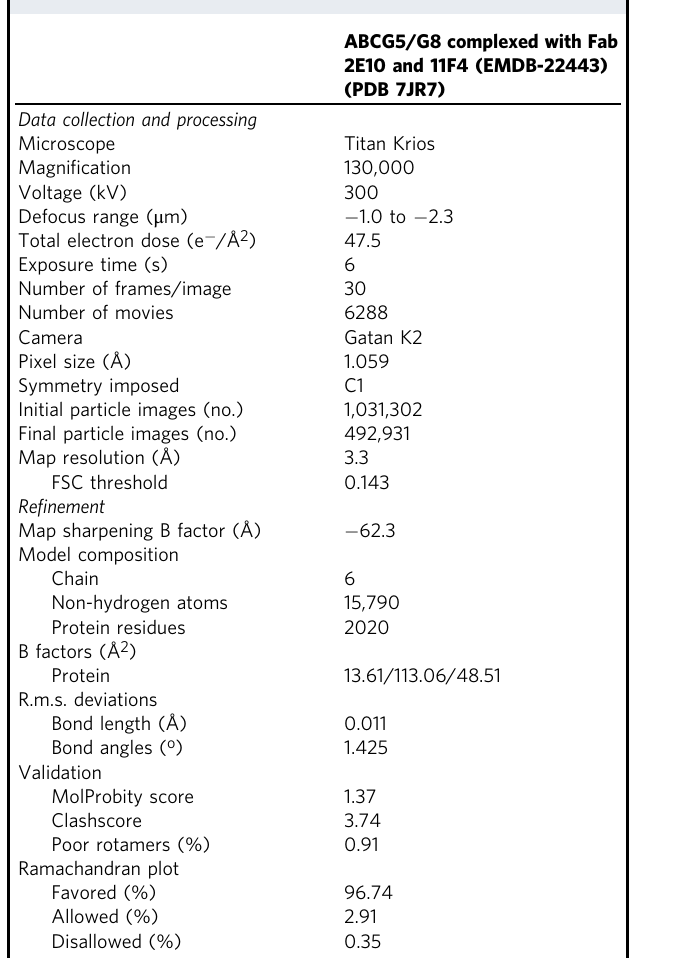
Table 1 Cryo-EM data collection, re fi nement and validation statistics.